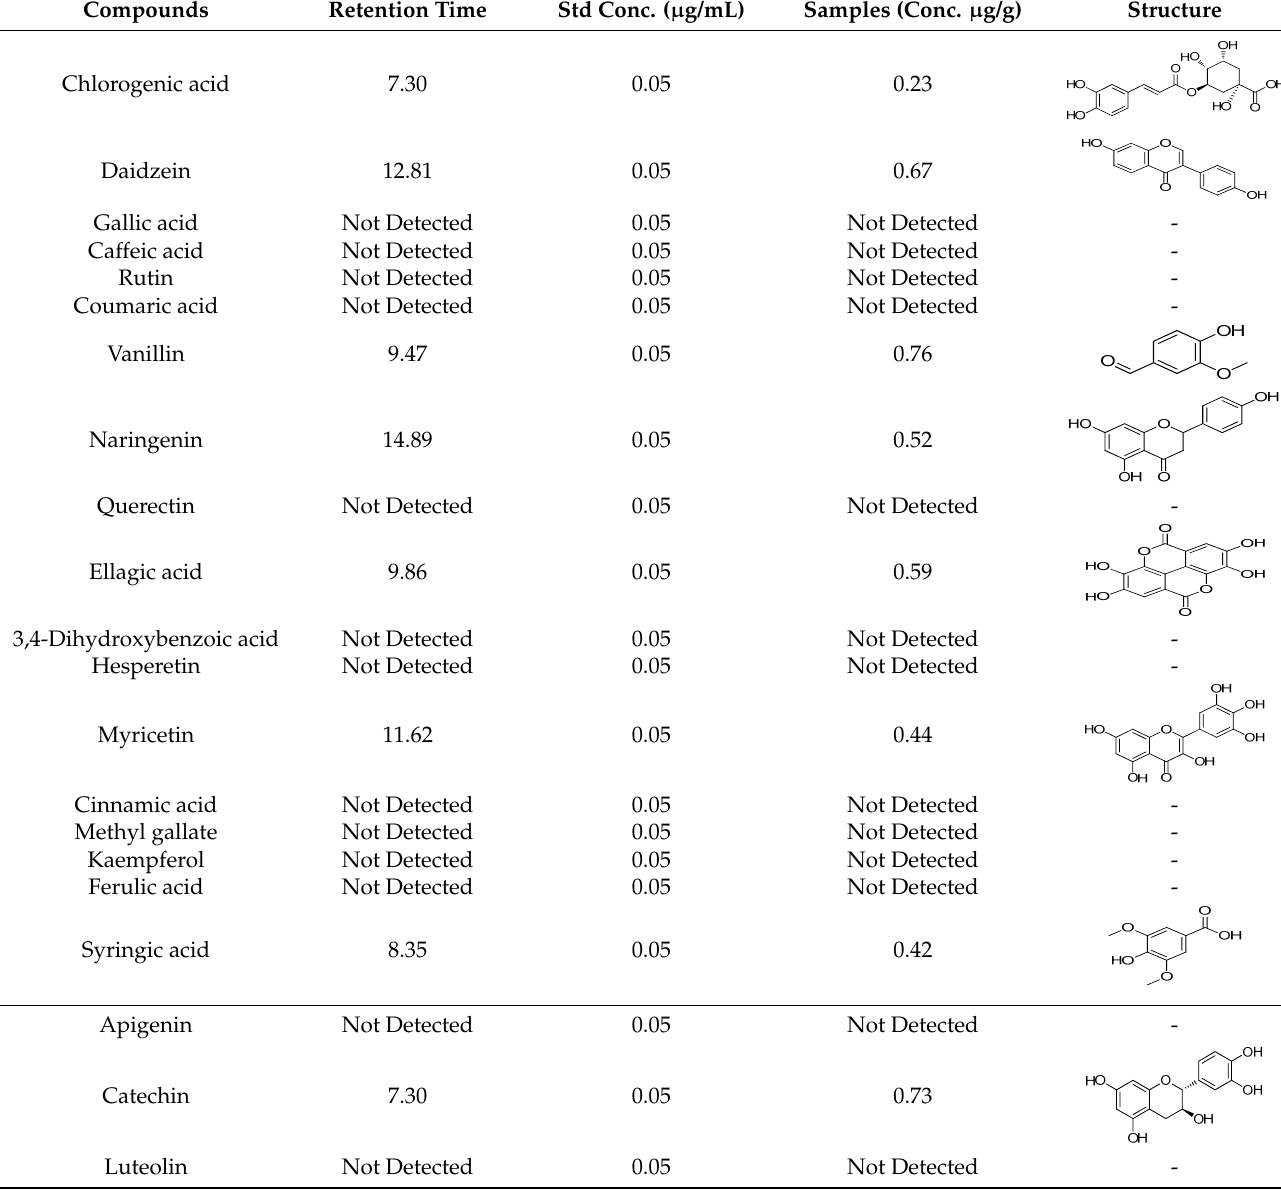
11 of 24 Table 1. LC MS/MS adsorbent composition of the active ingredient from MgAl-LDH intercalated Table 1. LC MS/MS adsorbent composition of the active ingredient from MgAl-LDH intercalated (Green Tea oil) after desorption by ethanol compared to standards. Table 1. LC MS/MS adsorbent composition of the active ingredient from MgAl-LDH intercalated (Green Tea oil) after desorption by ethanol compared to standards. Table 1. LC MS/MS adsorbent composition of the active ingredient from MgAl-LDH intercalated Std Conc. Compounds Retention Time (Green Tea oil) after desorption by ethanol compared to standards. Table 1. LC MS/MS adsorbent composition of the active ingredient from MgAl-LDH intercalated (Green Tea oil) after desorption by ethanol compared to standards. Table 1. LC MS/MS adsorbent composition of the active ingredient from MgAl-LDH intercalated (Green Tea oil) after desorption by ethanol compared to standards. Table 1. LC MS/MS adsorbent composition of the active ingredient from MgAl-LDH intercalated (Green Tea oil) after desorption by ethanol compared to standards.